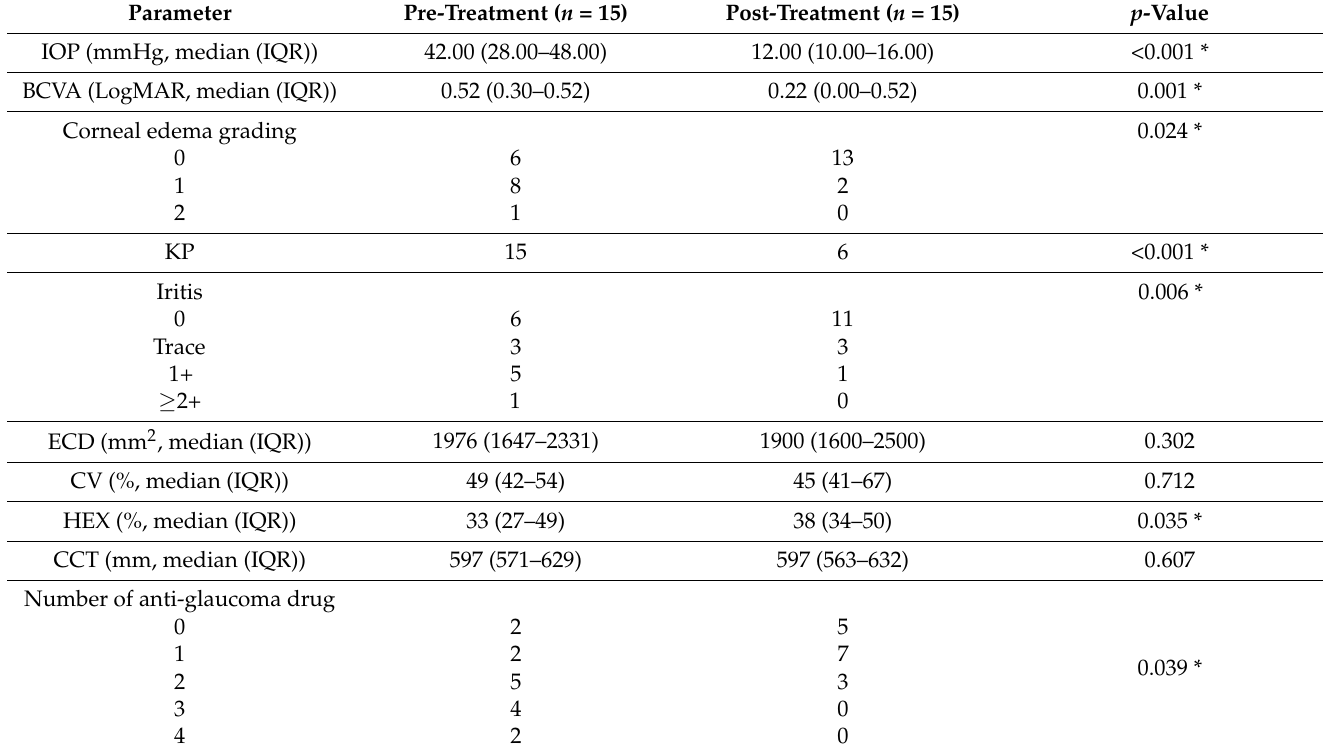
Table 1. The Ophthalmic Parameters Before and After Treatment in Cytomegalovirus Corneal